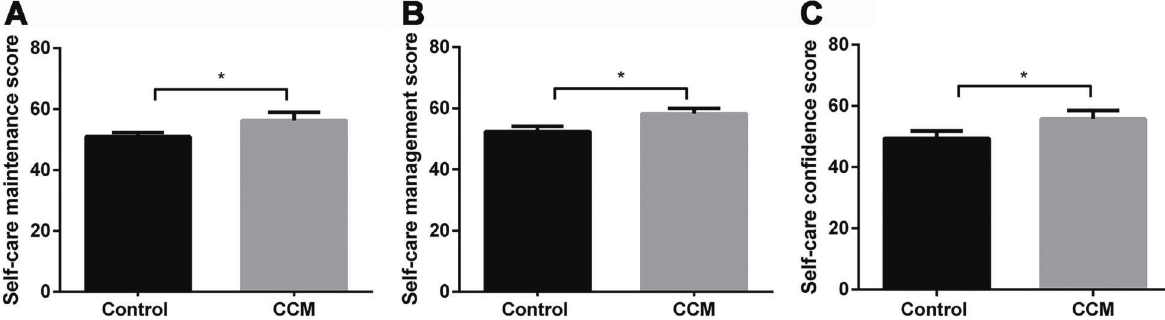
Figure 1. Comparison of A , self-care maintenance; B , self-care management, and C , self-care con fi dence between patients with chronic heart failure treated with usual care (Control) and with the collaborative care model (CCM). Data are reported as means ± SD. *P o 0.05 ( t -test).